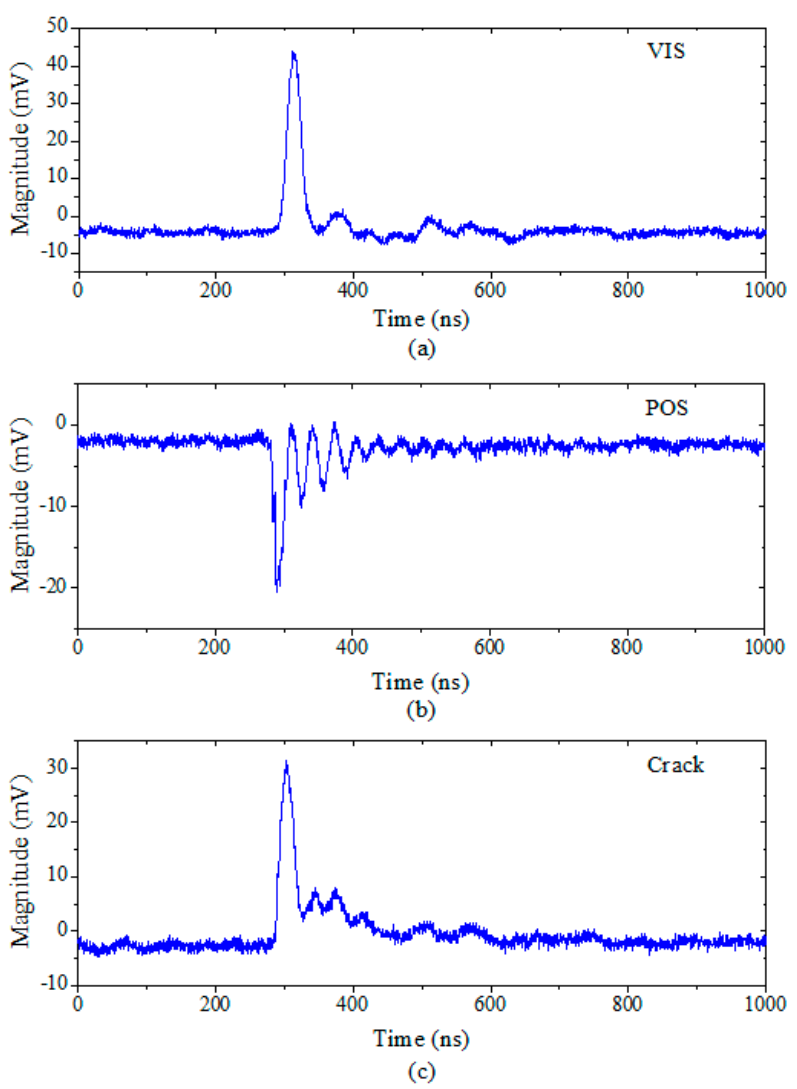
Figure 4. Typical detected PD pulses. ( a ) In the void inside spacer (VIS); ( b ) in the POS; ( c ) in the